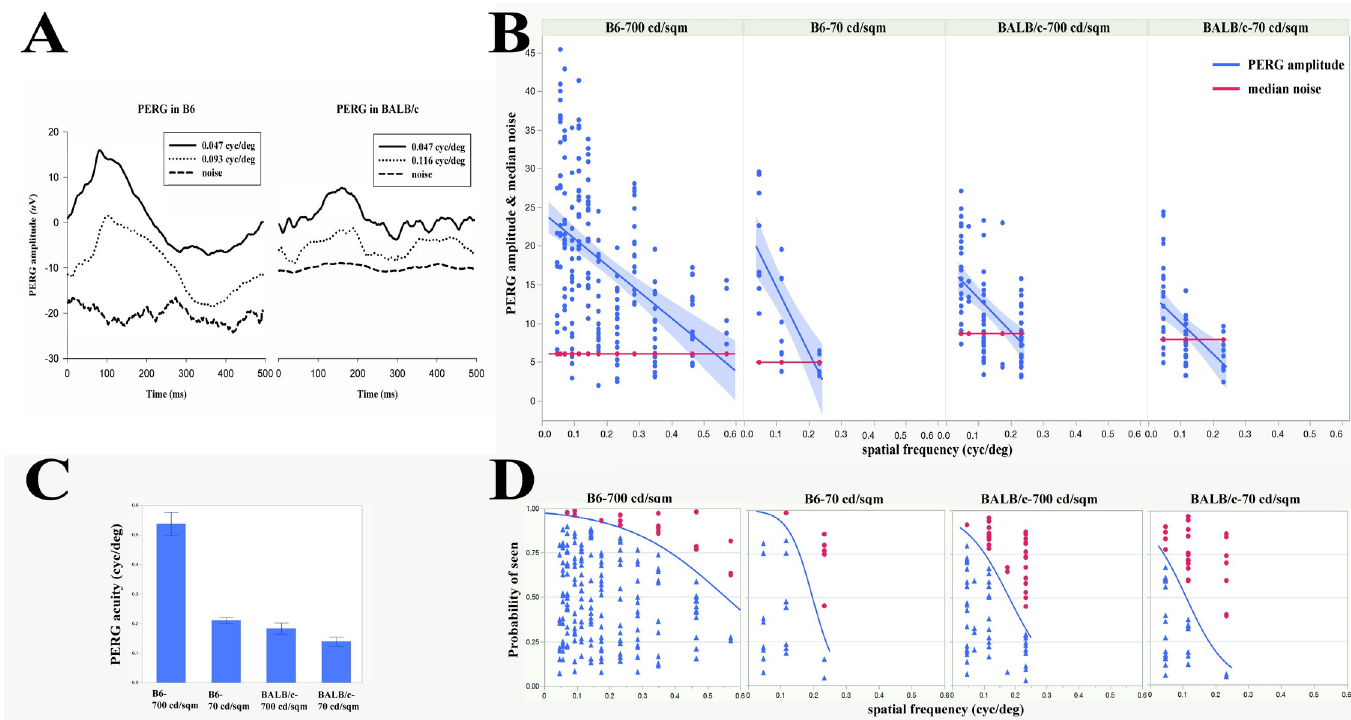
Fig 1. Comparison between PERG acuity of C57BL/6J and BALB/c mice. (A) Examples of PERG and noise waveforms from B6 and BALB/c mice at different spatial frequencies and 700 cd/m 2 mean luminance. (B) PERG amplitudes as a function of spatial frequency for all mice. Linear regressions of PERG amplitude (blue lines with 95% confidence region) intersect the median noise level (red lines) at different spatial frequencies depending on strain and mean luminance. (C) Mean PERG acuity ( ± SEM) in B6 and BALB/c in individual mice calculated by linear extrapolation of PERG amplitude to the median noise. (D) Group PERG acuity assessed with the nominal logistic fit showing that acuity depends on strain and luminance. The estimated acuity is the intersection of the logistic curve (blue line) with the 0.50 probability grid line). Data points (blue triangles: SNRs > 1, YES; red circles: SNRs � 1, NO) are jittered along the vertical axis, with no reference to the axis probability scale.